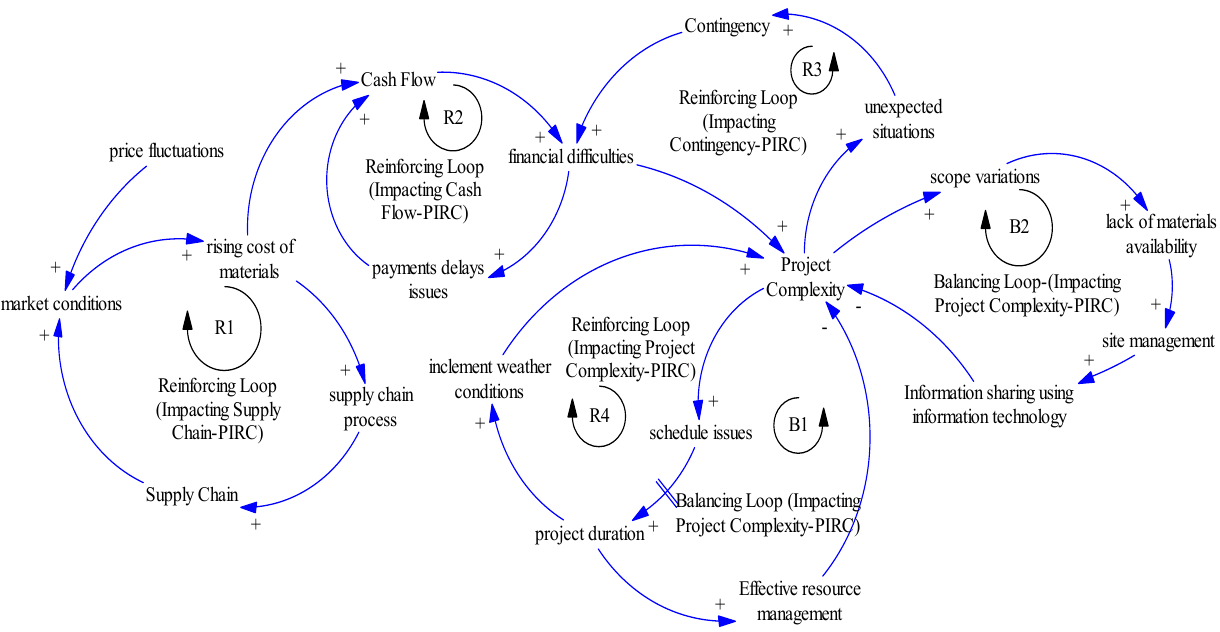
Figure 2. Causal loop diagram based on systems thinking of balancing and reinforcing loops.